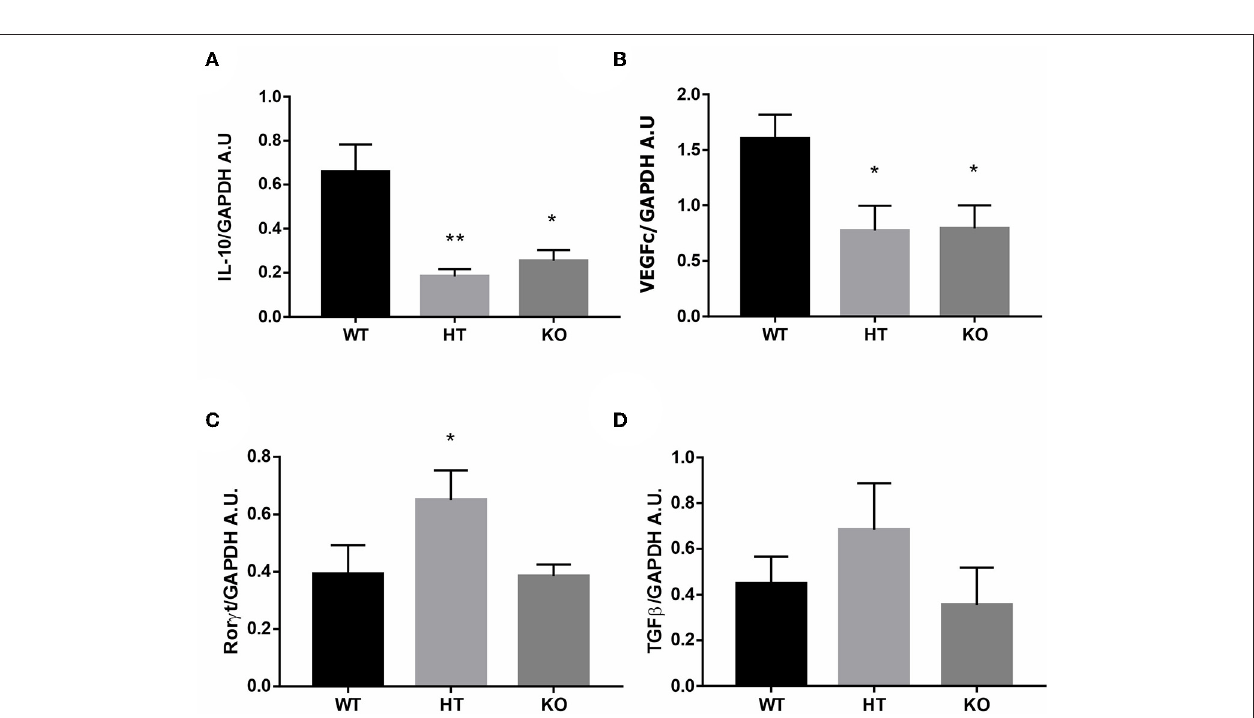
FIGURE 2 | Vasoactive intestinal peptide (VIP)-deficient mice show a hostile microenvironment in estrus uterus. The estrous cycle was evaluated in VIP − / − , VIP + /–, and VIP + / + female using vaginal lavage. At estrus, mice were sacrificed, and uterus was removed for RT-PCR analysis. (A) IL-10, (B) VEGFc, (C) ROR γ t, and (D) TGFß expression. Bands were semiquantified with ImageJ ® , and intensity was expressed in arbitrary units (AU) relative to GAPDH. Values represent mean ± SEM of at least seven experiments (ANOVA test, Dunn’s posttest * p < 0.05 and ** p <